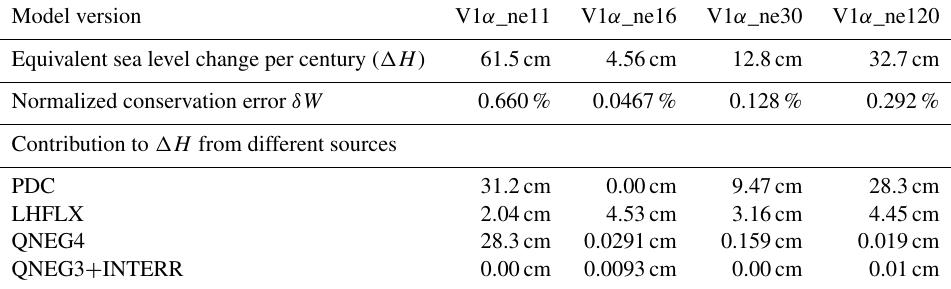
Table 5. Water conservation error in 5-day atmosphere-only simulations conducted with the default E3SM V1 α model at different horizontal resolutions. The model configurations, including the time step sizes for various parts of the model, are summarized in Table 4. The equivalent sea level change is calculated using Eq. (6). The normalized conservation error is calculated using Eq.